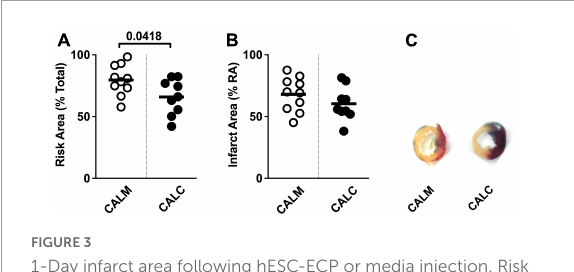
FIGURE3 1-Day infarct area following hESC-ECP or media injection. Risk area (%) of LV area below the suture (A) , infarct area,% (B) within the risk area, and (C) representative sections 1 d post-infarct in CALM, n = 11, and CALC, n = 10 groups. Student’s t -test; data are presented as individual points and as mean ±